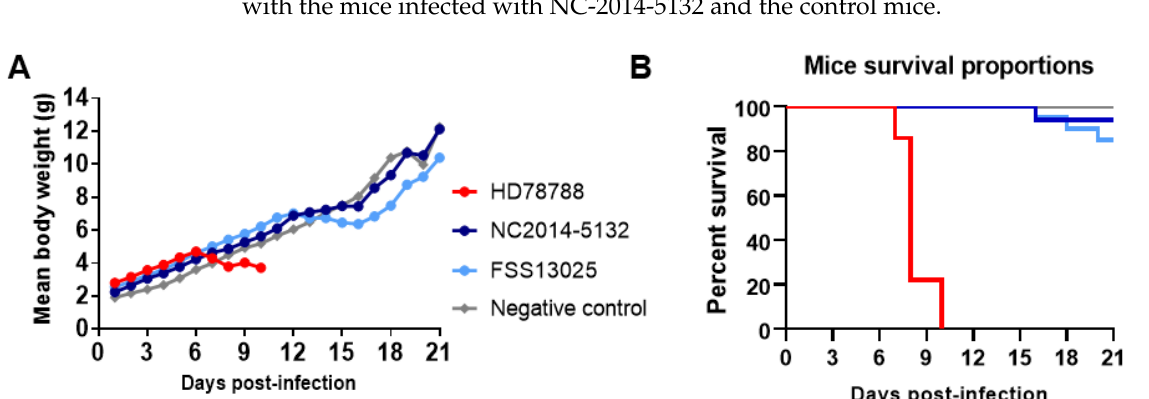
Figure 4. ZIKV infection in neonatal Swiss mice. Mice were infected with ZIKV HD78788 (red), NC-2014-5132 (dark blue), or FSS13025 (light blue) at the age of one day old. Body weight ( A ) was checked every day and survival was monitored for 21 days ( B ).